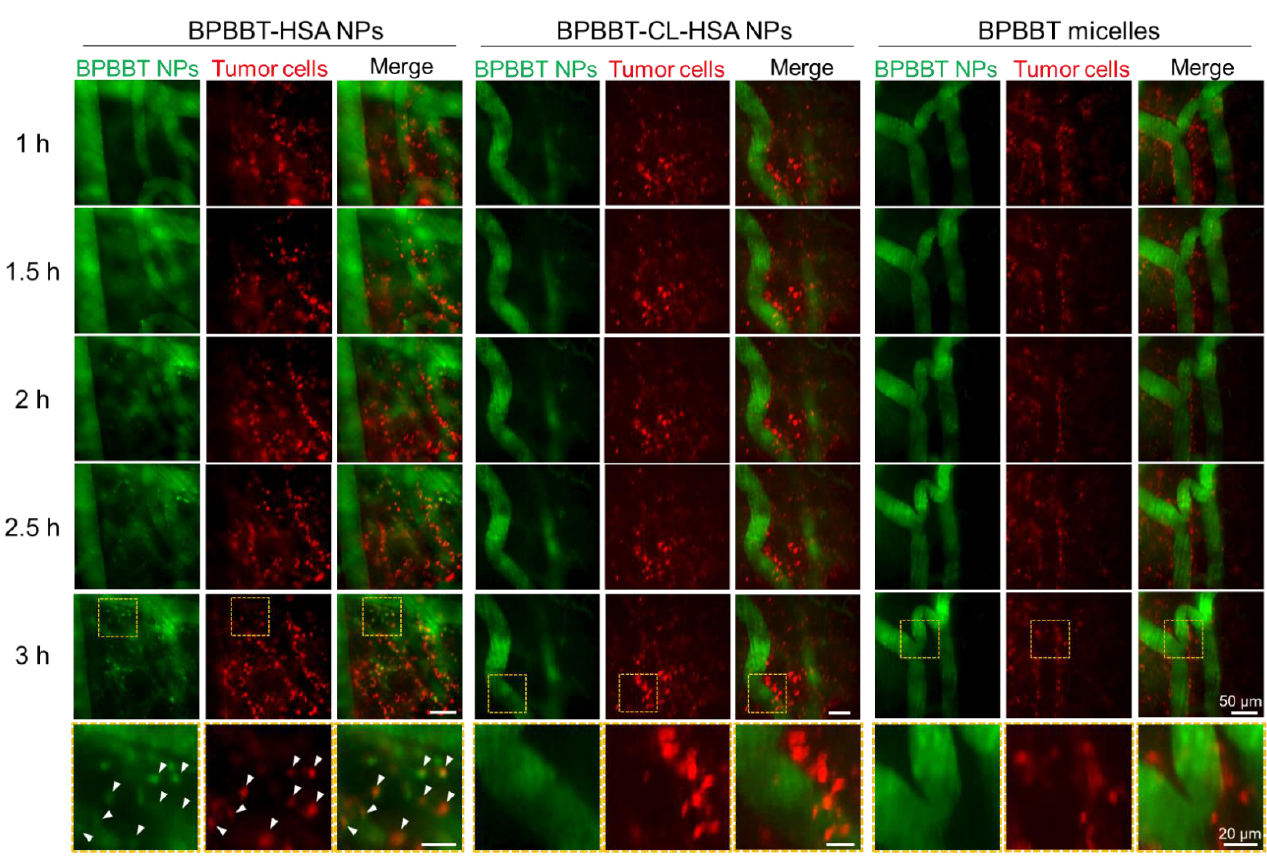
Figure 7. Intravital imaging of different types of BPBBT NPs in the orthotopic CT26-Luc tumor of mice after the i.v. injection (20 mg/kg of BPBBT). The tumor cells were labeled with DiD before the inoculation. Green, BPBBT NPs; red, the DiD-labeled tumor cells. The imaging started at 1 h and ended at 3 h post-injection of the nanoparticles. The box area of images at 3 h post-injection were enlarged and presented in the bottom row. Arrows,